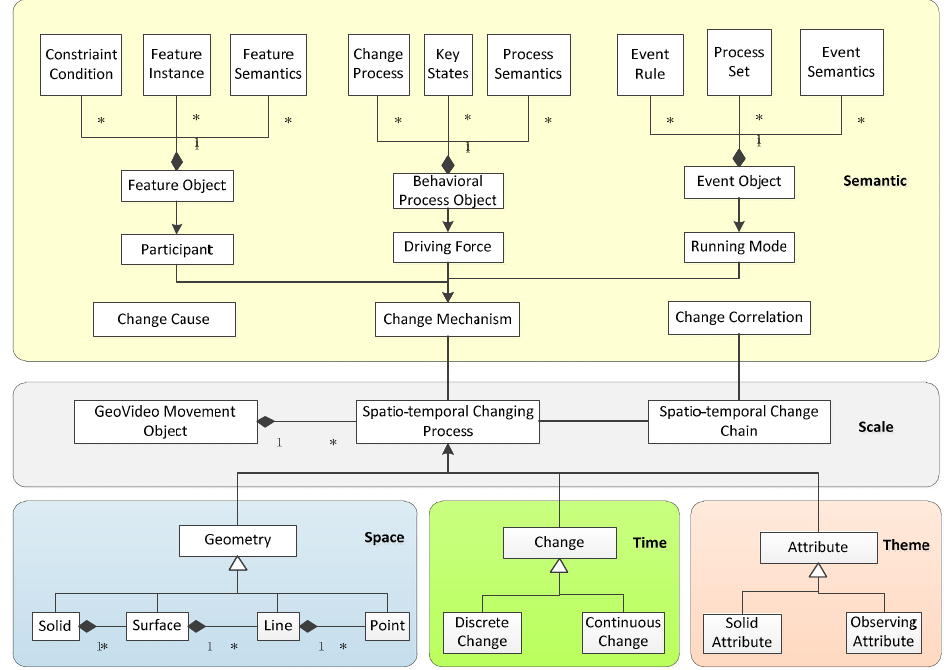
Figure 2. The unified expression of the heterogeneous GeoVideo data.